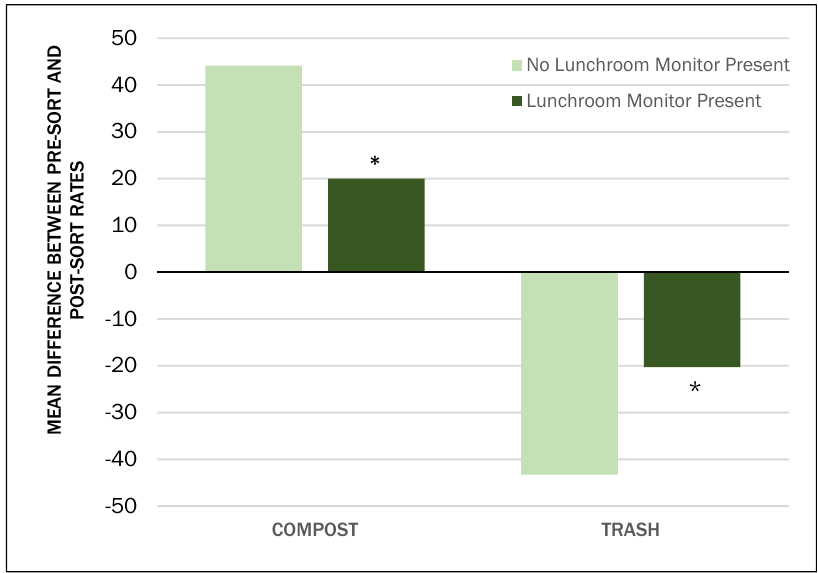
Figure 5. Effect of Lunchroom Monitors on Compost and Trash Rates